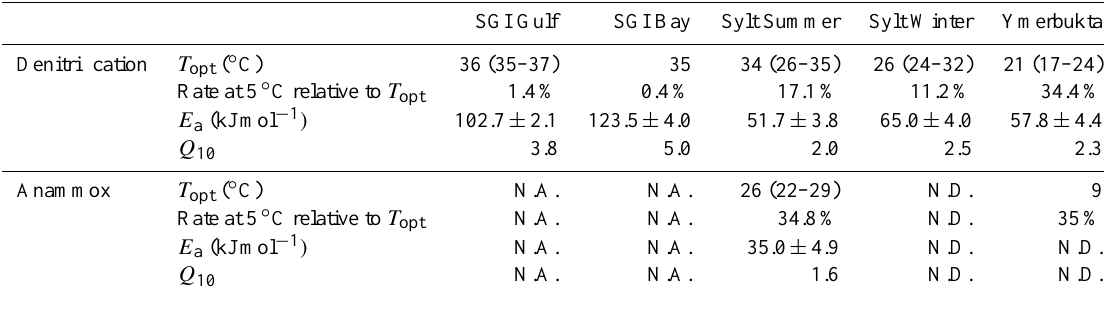
Table 3. Optimum temperatures ( T opt ) , apparent activation energy ( E a ) , and ratio of rates at 5 ◦ C relative to T opt for anammox and denitrifi- cation in permeable sediments. The range of the T opt peak where rates did not fall below 90% of the optimum rate is noted in parentheses. Values of Q 10 were calculated between T opt and T opt − 10 ◦